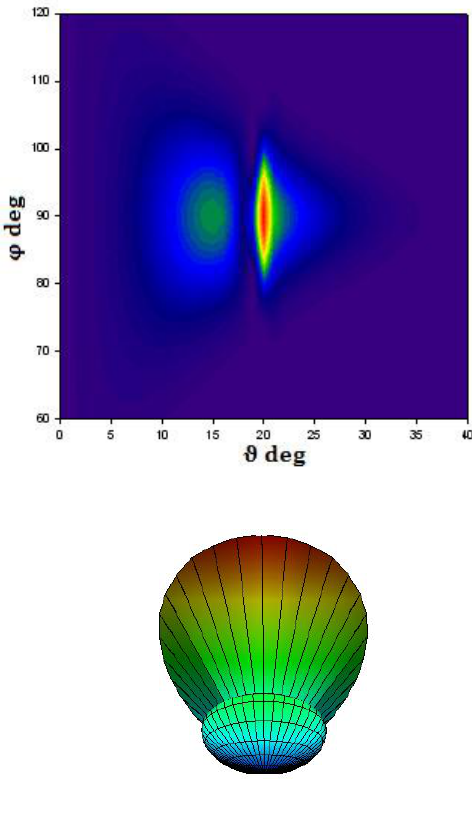
Figure 6a: The pattern of reflected field f =37,2